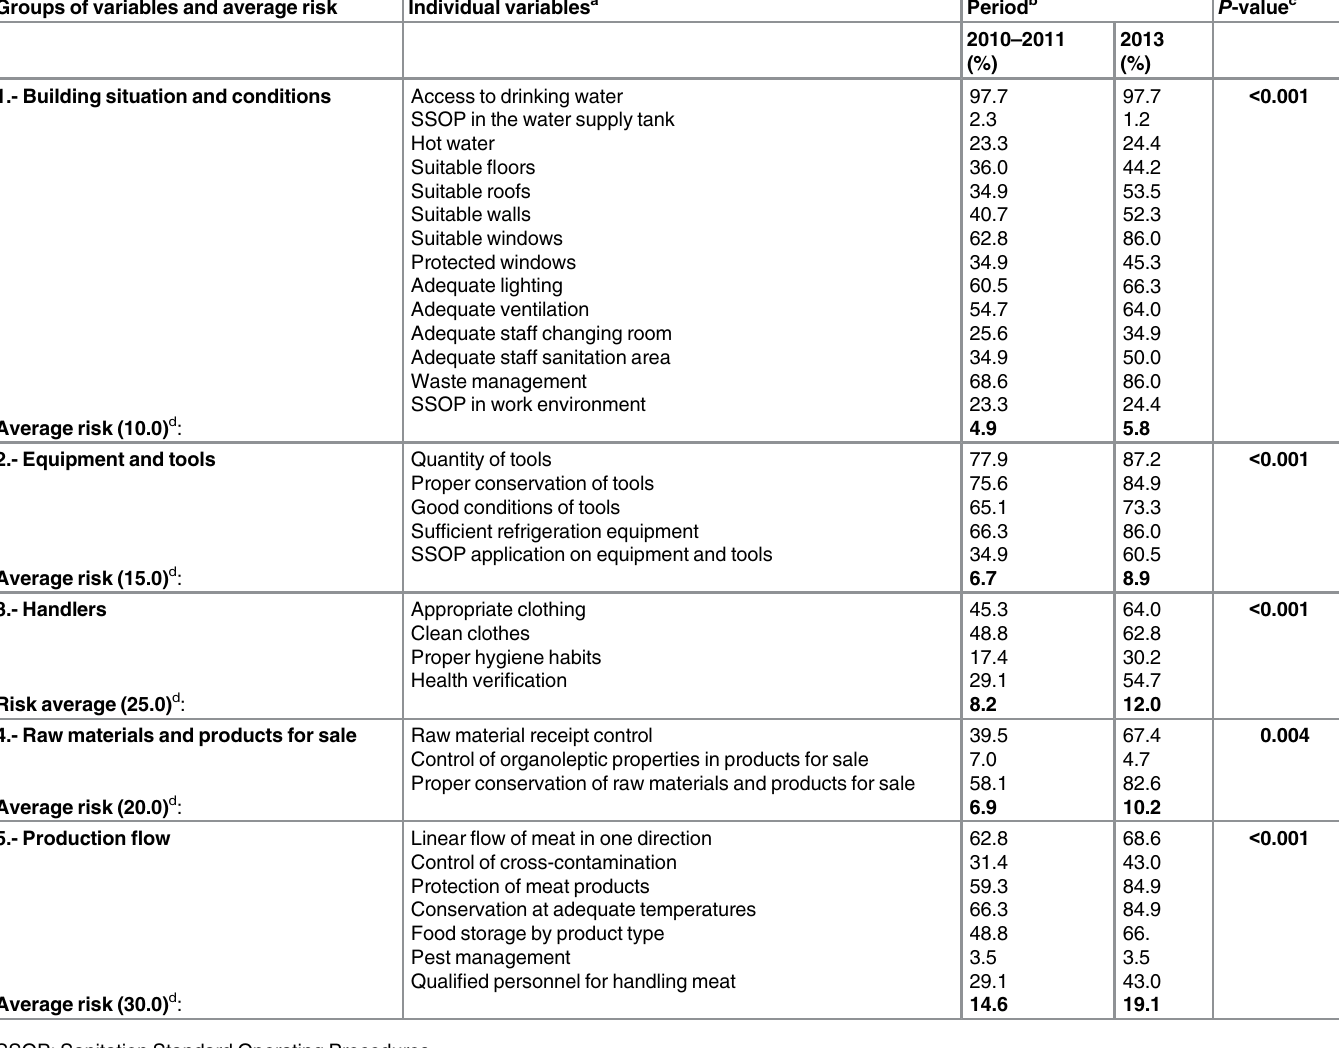
Table 1. Average risk of each group of variables during the evaluation (2010 – 2011) and verification (2013) periods. Groups of variables and average